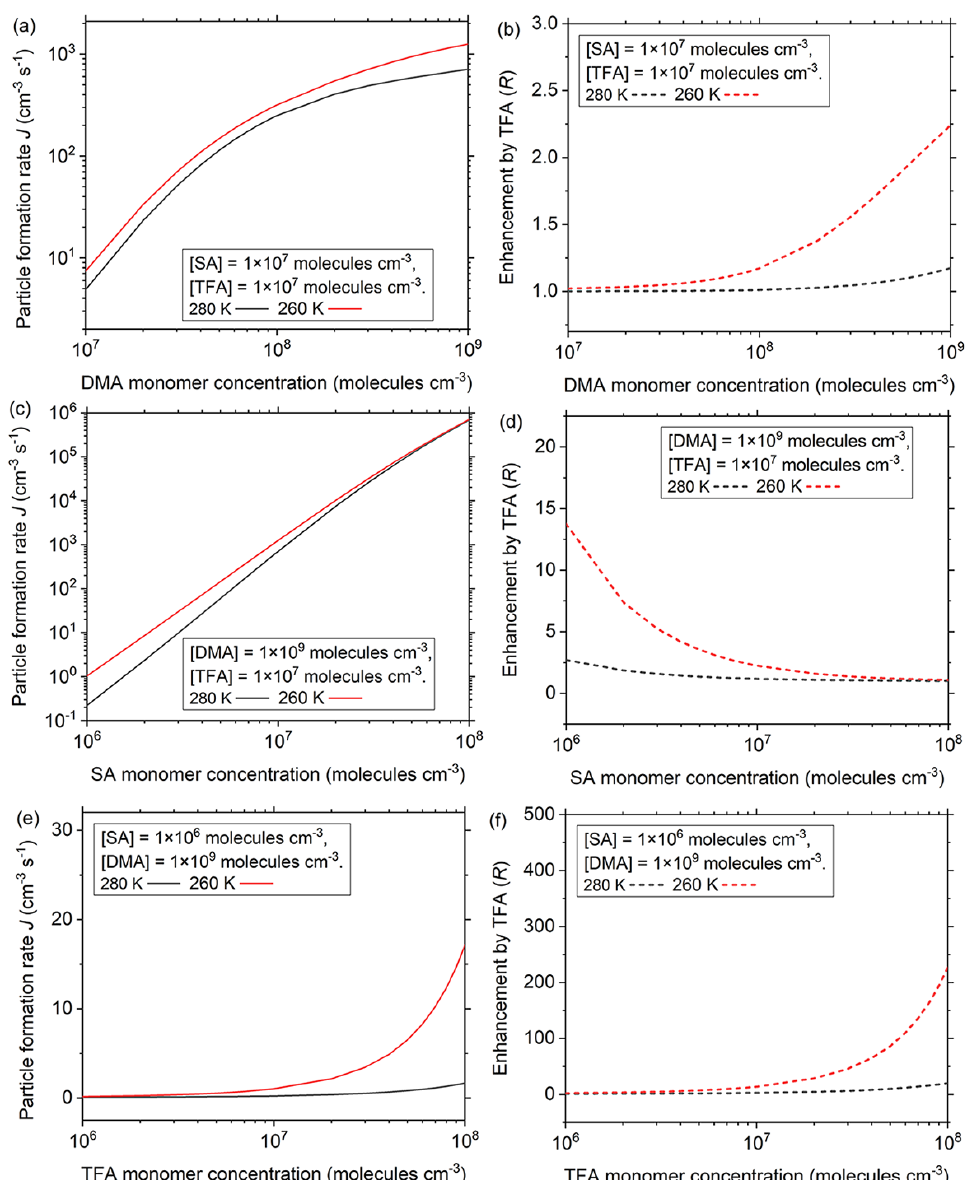
Figure 3. Particle formation rates ( J , cm − 3 s − 1 ) at different temperatures (280 and 260K) as a function of (a) DMA monomer concen- trations, (c) SA monomer concentrations, and (e) TFA monomer concentrations. Enhancement on particle formation rate by TFA ( R , R = J SA-DMA-TFA /J SA-DMA ) at different temperatures as a function of (b) DMA monomer concentrations, (d) SA monomer concentrations, and (f) TFA monomer concentrations. Black and red lines are corresponding to 280 and 260K, respectively. CS = 0.02s − 1